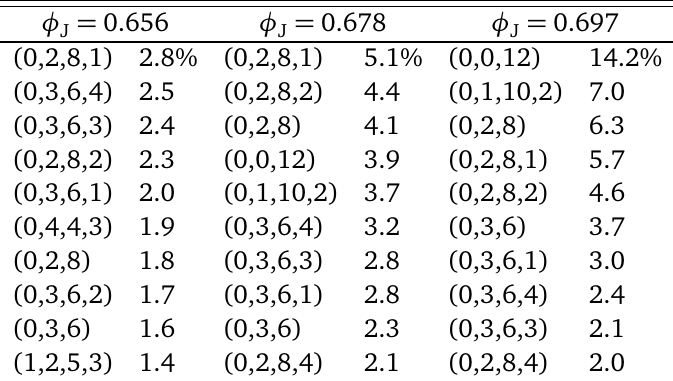
Table 1: Most frequent Voronoi signatures and the corresponding average percentages in jammed configurations. The corresponding parent fluid packing fractions are φ ( N = 8000 ) , 0.618 ( N = 8000), and 0.655 ( N = 1000), respectively. Figs. 4(c, d), we show the fraction f ( states. As for panels (a) and (b), we plot the data as a function of φ